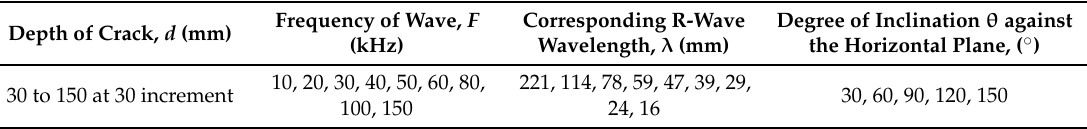
Table 2. Orientation, degree and depth of